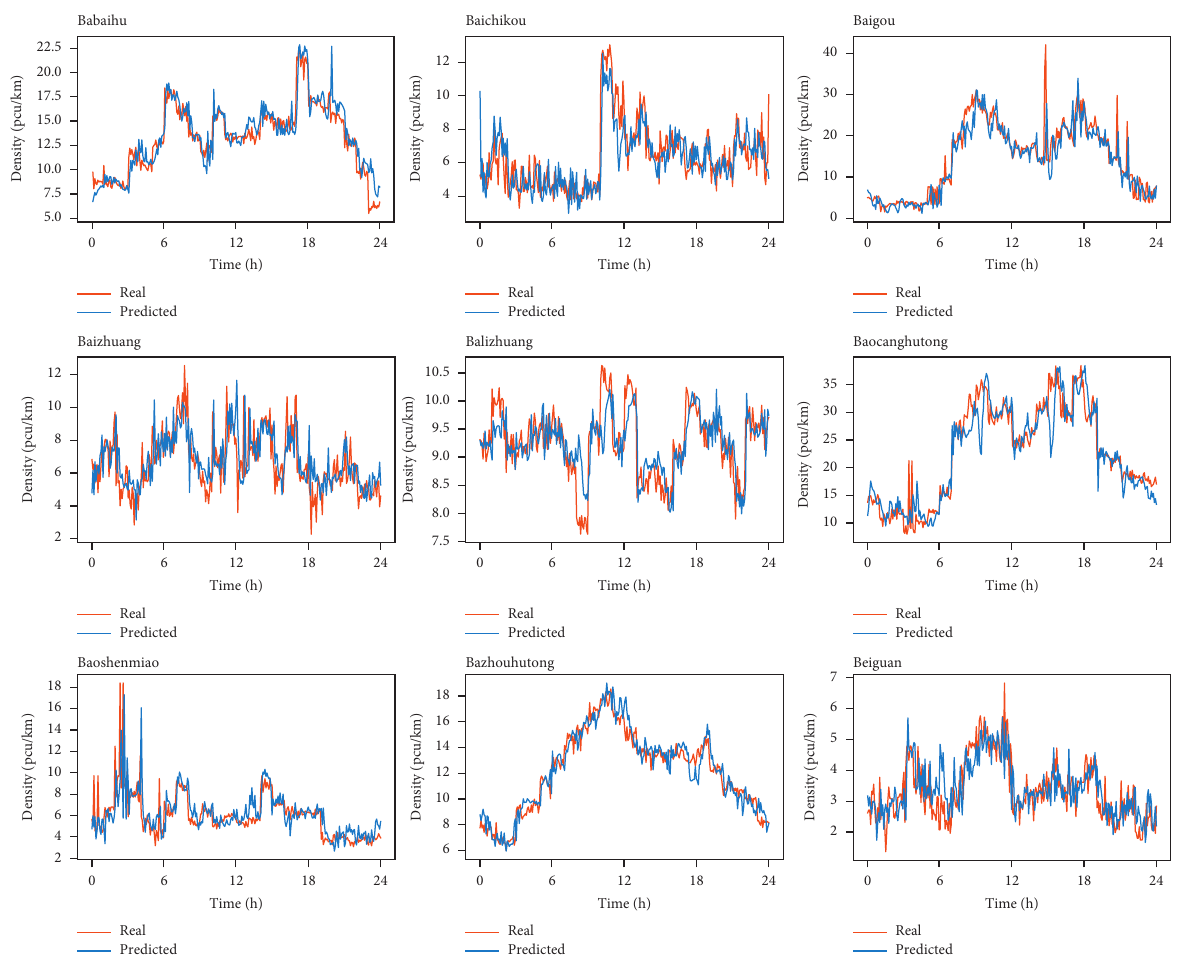
Figure 4: Comparison of predicted density and true density in 9 observation